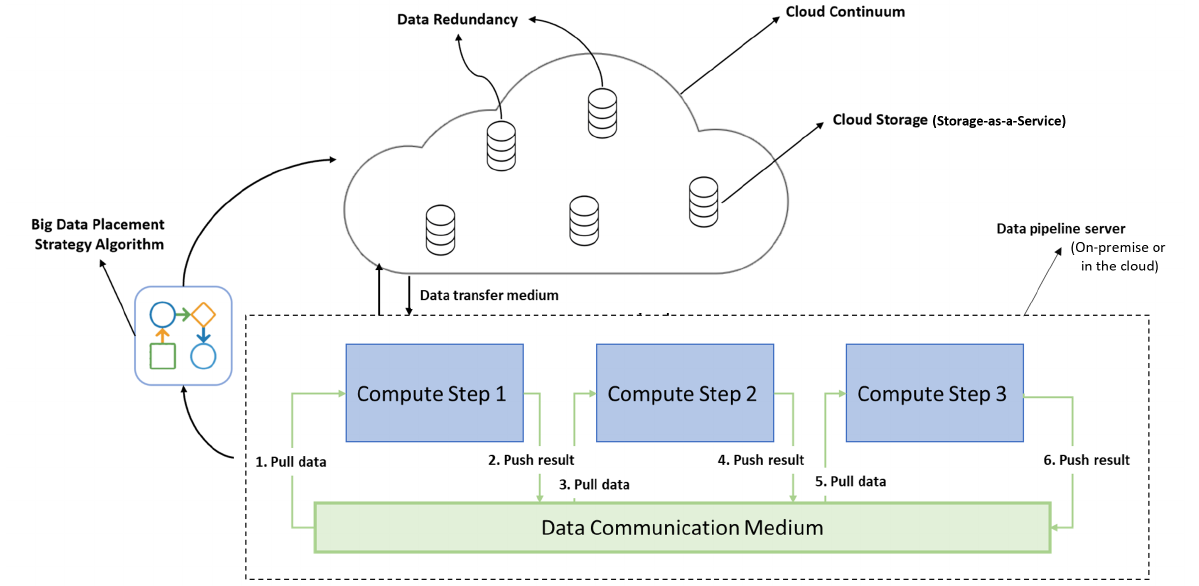
Figure 3. Smart data placement using storage-as-a-service